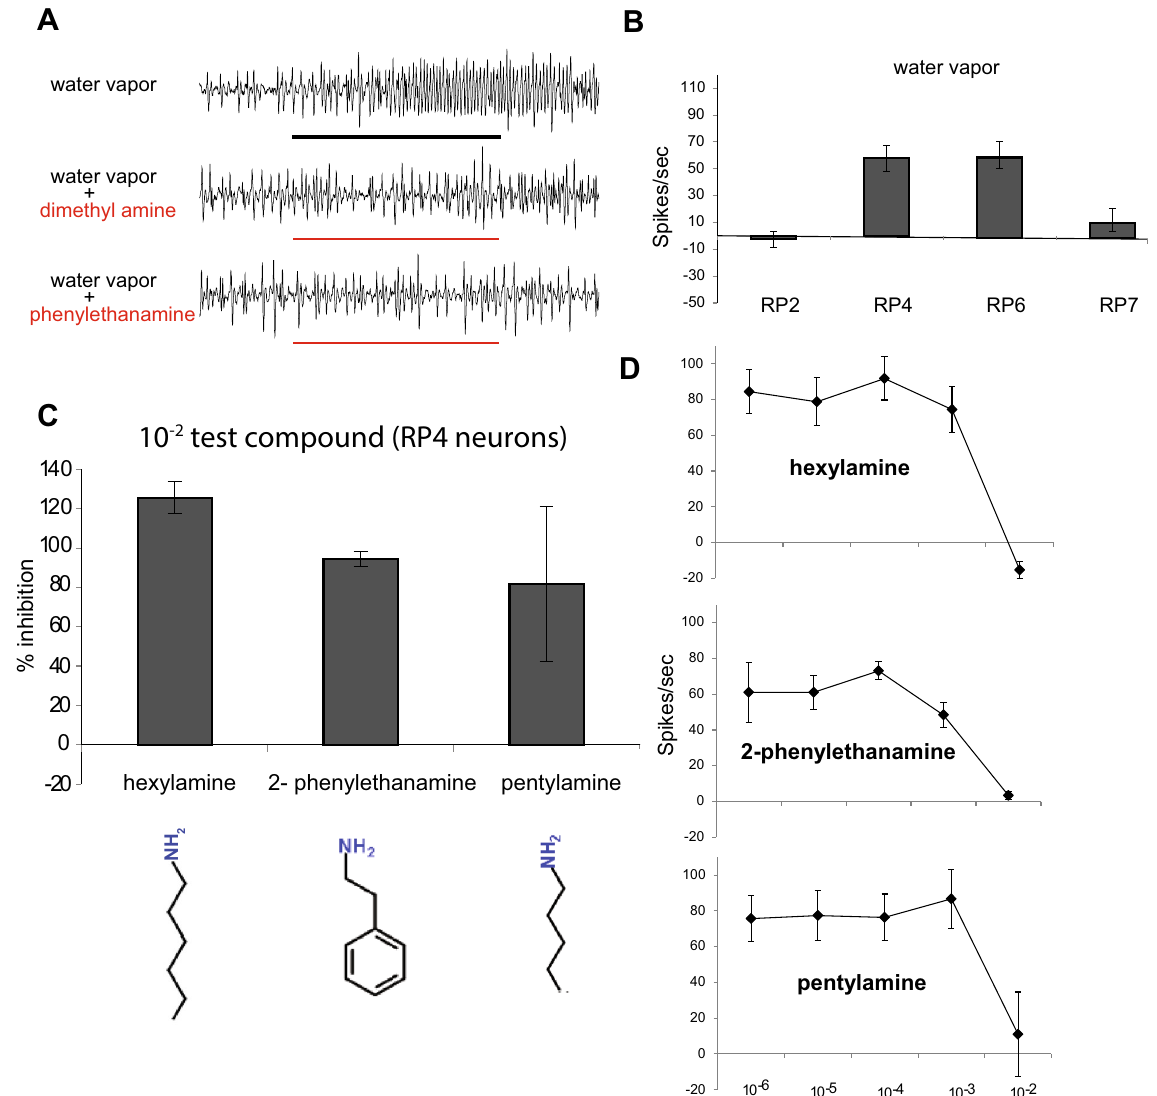
Figure 1. ( A ) Representative traces of neurons from the Asian citrus psyllid (ACP) RP4 sensillum during exposure to a 1-s stimulus of water vapor alone (top), or water vapor coapplied with dimethylamine (middle) and 2-phenylethanamine (bottom). The stimulation period is indicated by the solid bars. Odorant headspace from a 10 –2 concentration solution was tested for each. ( B ) Mean responses for a 1-s period of stimulation from each ACP RP sensillum in response to water vapor alone. n = 3 sensilla from 3 psyllids. Error bars indicate s.e.m. ( C ) Mean percent inhibition of ACP RP4 neural activity caused by 1% concentration of each of the three displayed compounds. n = 3 sensilla from 3 psyllids. Error bars indicate s.e.m. ( D ) Mean neuronal activity in spikes per second of the ACP RP4 neuron caused by the three displayed compounds across several concentrations. n = 3 sensilla from 3 psyllids. Error bars indicate